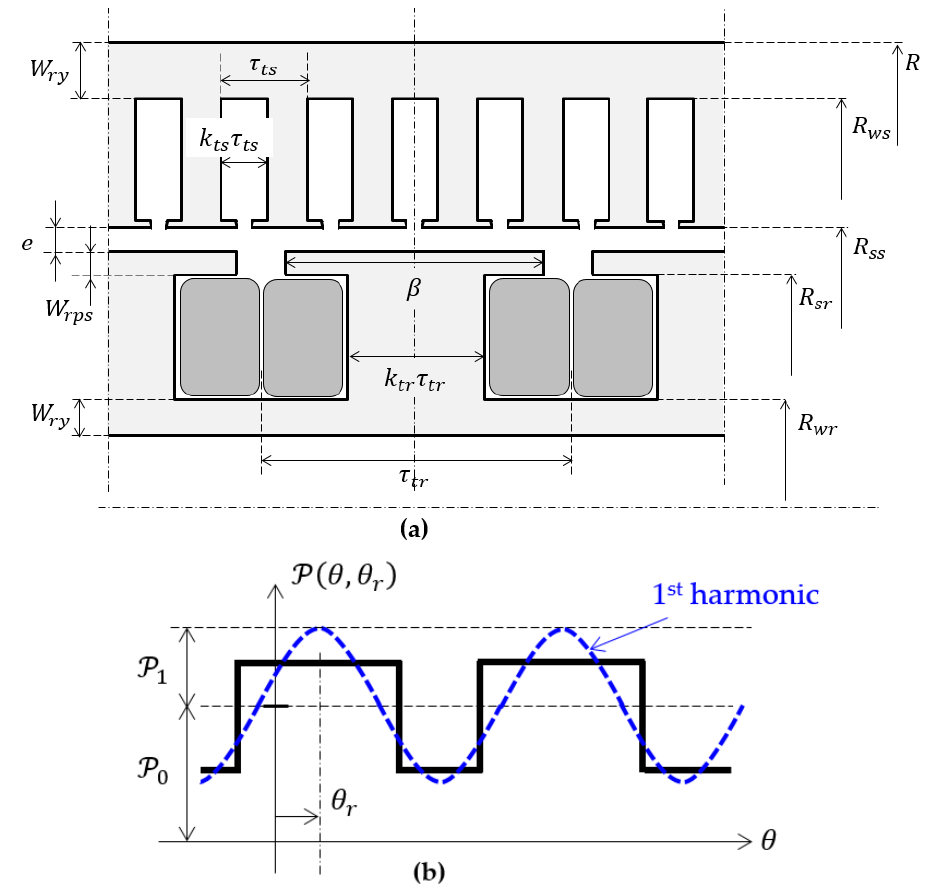
Figure 3. ( a ) Design of pole pitch with two slots/phase/pole and main geometric parameters, ( b ) Estimation of the permeance function.